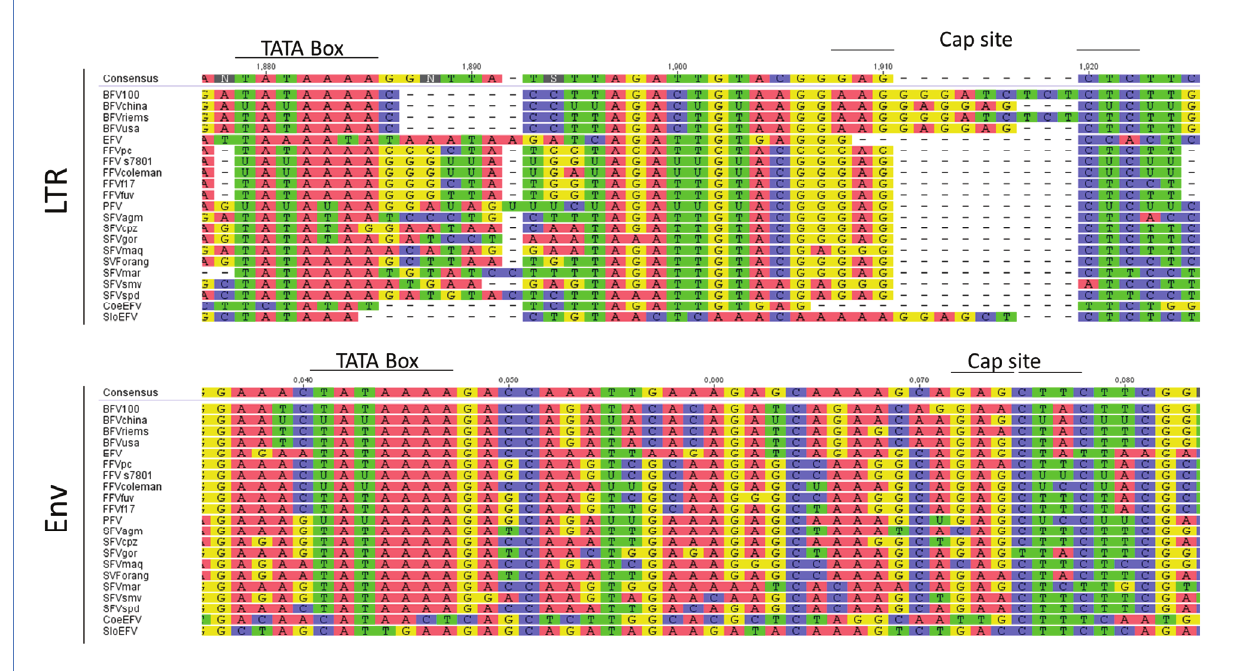
Figure 7. Multiple genomic sequence alignment of the TATA box motifs in FVs: All FVs sequences used are displayed in Table 2. As sequences have been selected according to the GenBank entries, some FV genomes are listed as RNA instead of DNA genomes, therefore containing uracil (U) instead of thymin (T). Alignments have been done for the LTR and env region. The consensus nucleotide sequence is listed at the top of each set with colored capital letters. Dashes indicate nucleotides missing in the isolates. The TATA box motifs are indicated by bold lines over the consensus sequence. The alignment was performed with a global alignment strategy with free ends and gaps by Needleman and Wunsch, using a Blosum62 cost matrix